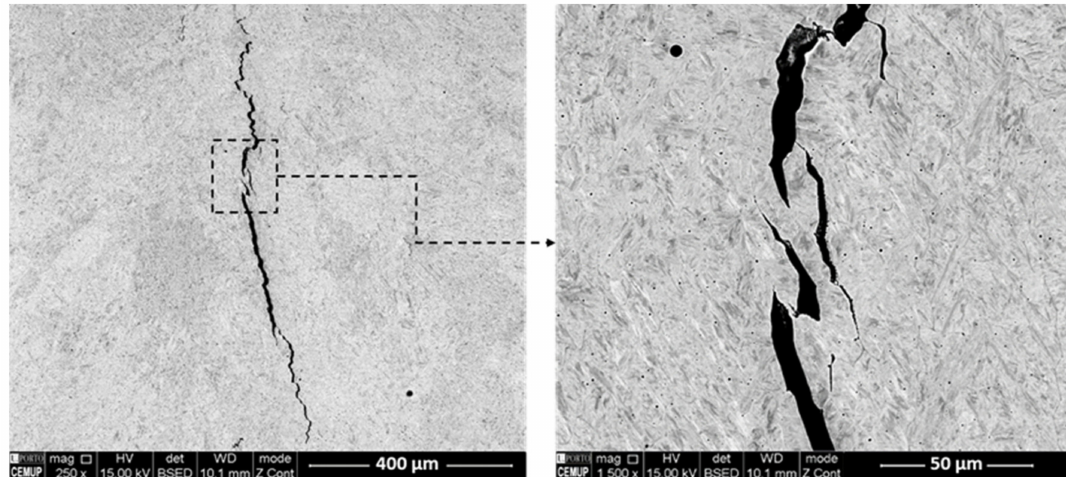
Figure 6. SEM images of cracks formed in the M2_6_15 sample with